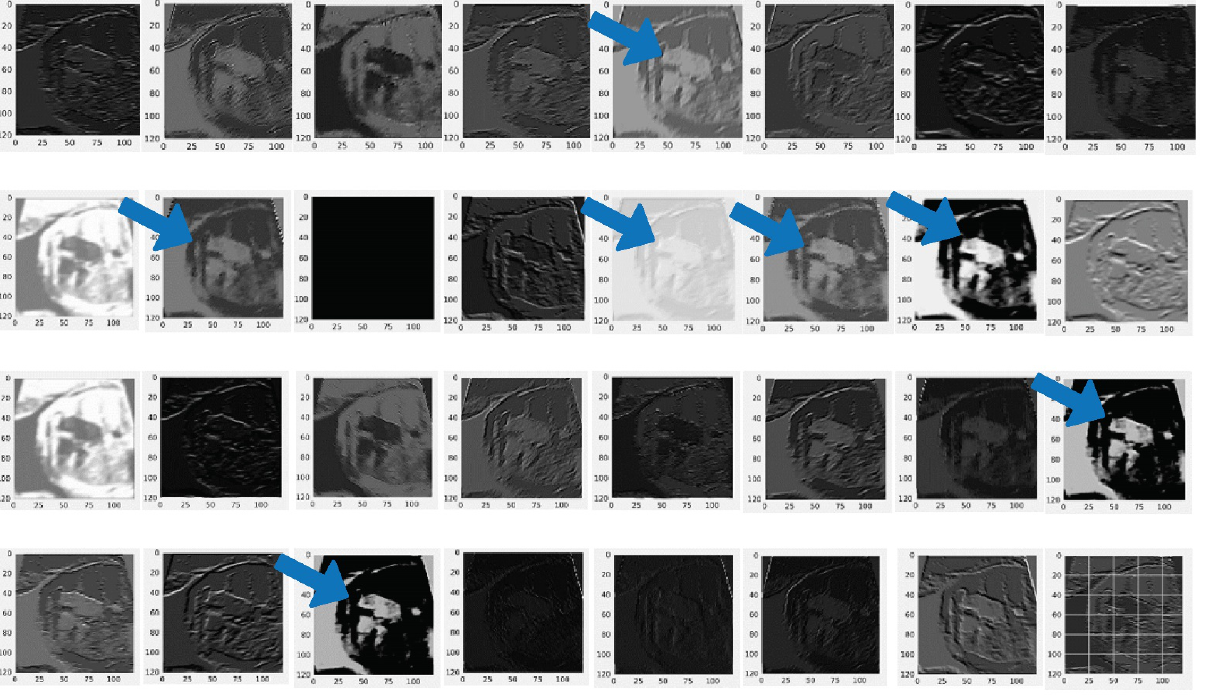
Figure 3. Feature extraction result from convolutional layer with DenseNet201 architecture. Blue arrow indicates the feature generated by from pooling layer in DenseNet 201. The feature maps are the bright areas (indicated by the blue arrow).